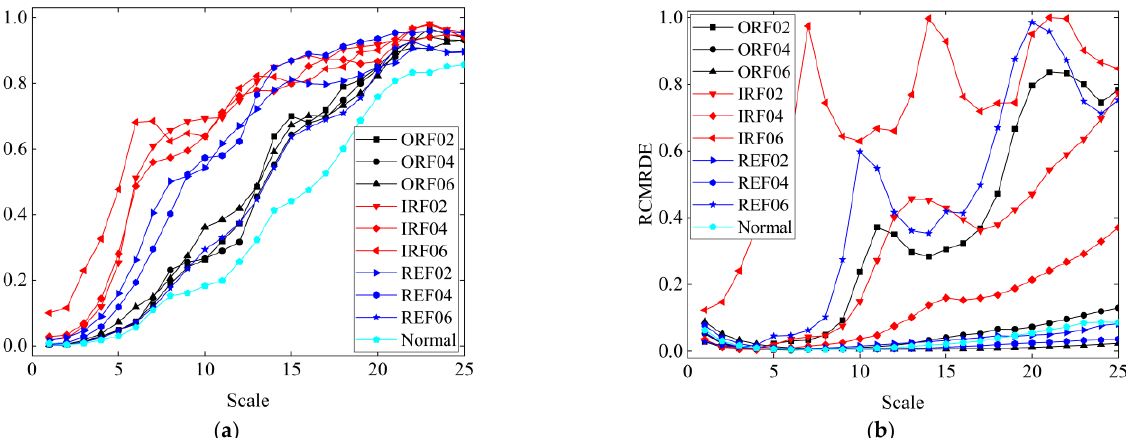
Figure 11. The RCMRDE values obtained under scale 25: ( a ) RCMRDE values of original signal; ( b ) RCMRDE values of the first IMF components.